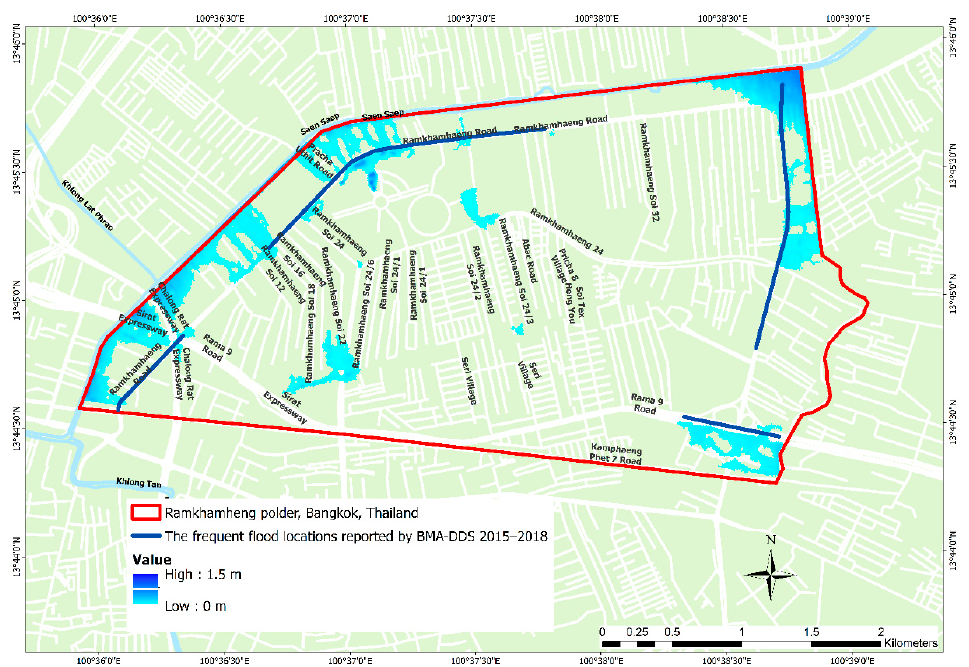
Figure 9. Comparison of flood locations recorded by BMA-DDS with those generated by PCSWMM between 2015 and 2018 at Ramkhamhaeng polder, Bangkok, Thailand.